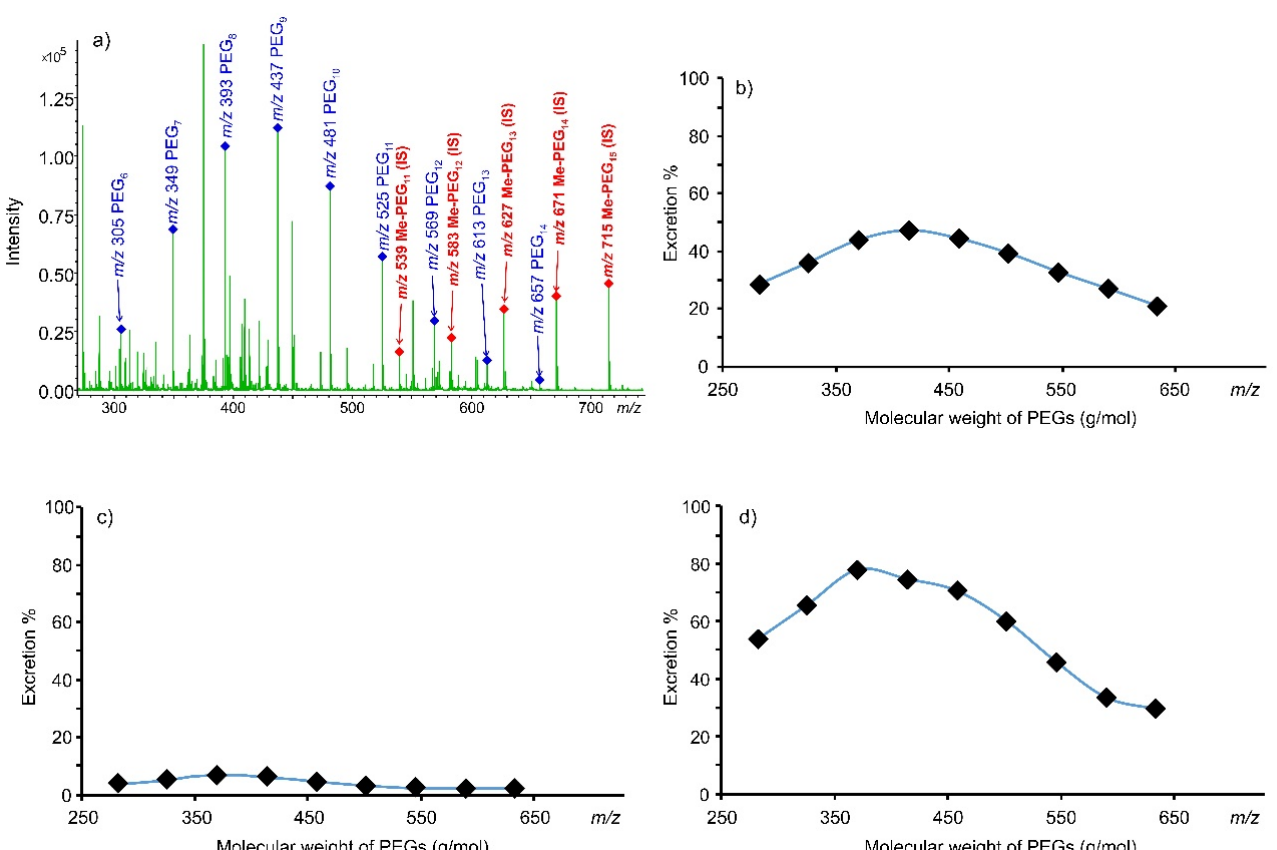
Figure 7. ( a ) MALDI-TOF mass spectrum of a urine sample from a volunteer following administration of PEG 400 spiked with 50 µL of mPEG as internal standard; ( b ) Excretion of the PEG 6-14 oligomers calculated by our method based on the spectrum shown to the left; ( c , d ) Extreme excretion examples. The size of the sample enables us to make a reliable statistical analysis about the intestinal permeability of the PEG 400 oligomers. The average excretion ratios are plotted in Figure 8, and the descriptive statistics are given in Table